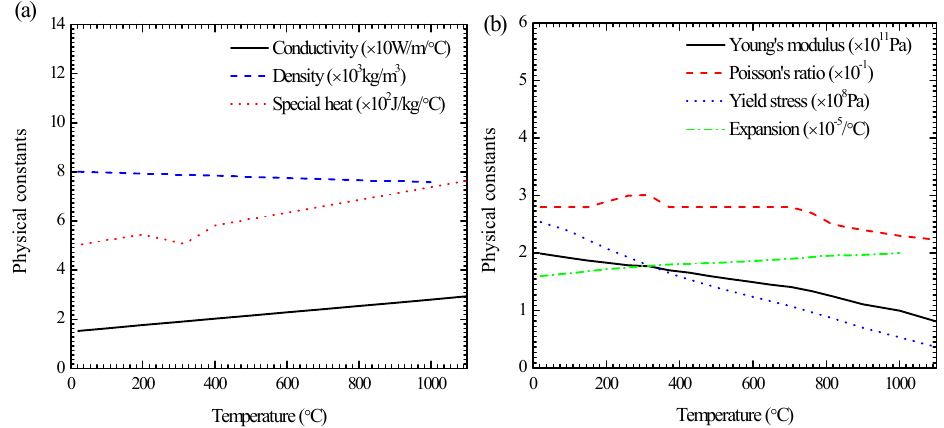
Figure 4. Temperature ‐ dependent thermal properties ( a ) and mechanical properties ( b ) of 304 steel.